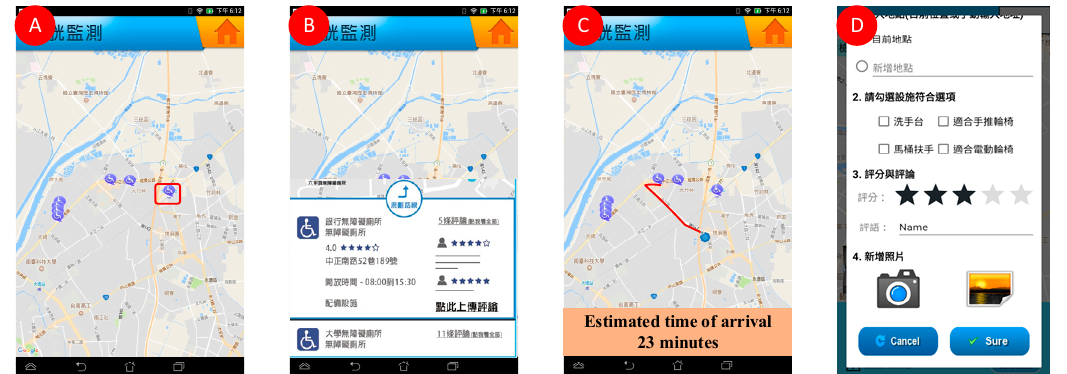
Figure 7. Accessible lavatory function of ( A ) list all the nearby accessible lavatories, ( B ) detailed information of each lavatory, ( C ) estimated time of arrival and ( D ) the interface of adding a new lavatory. Table 5. Accessible toilet arrival time in different environments without/with accessible lavatory function.